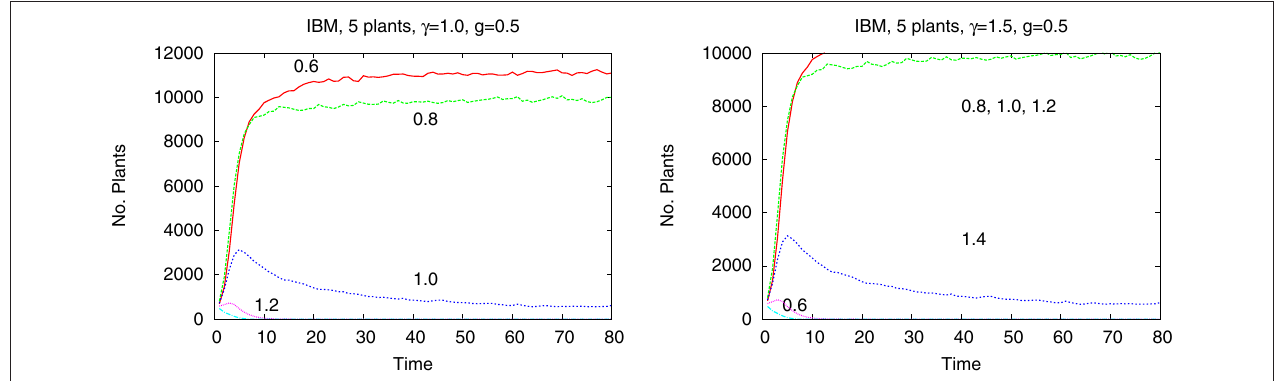
FIGURE 4 | Number of plants of five types as a function of time in heterogeneous habitat. Left panel γ = 1.0, right panel γ = 1.5, IBM approach. Shown is a restricted time interval.